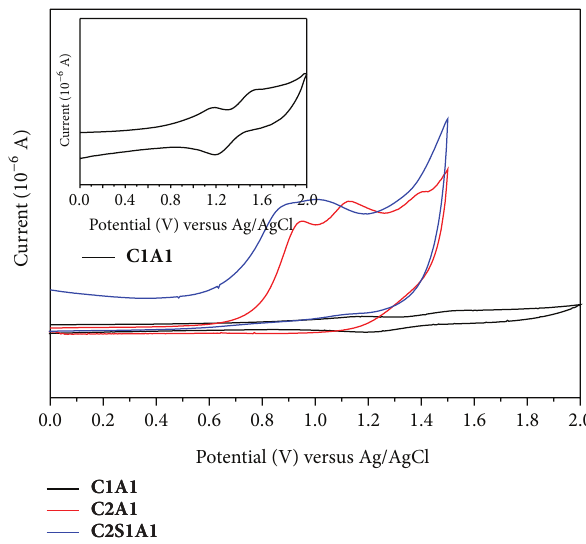
Figure 1: Absorption spectra for organic dyes in chloroform solution. Figure 2: The cyclic voltammetric curves of the dyes in chloroform